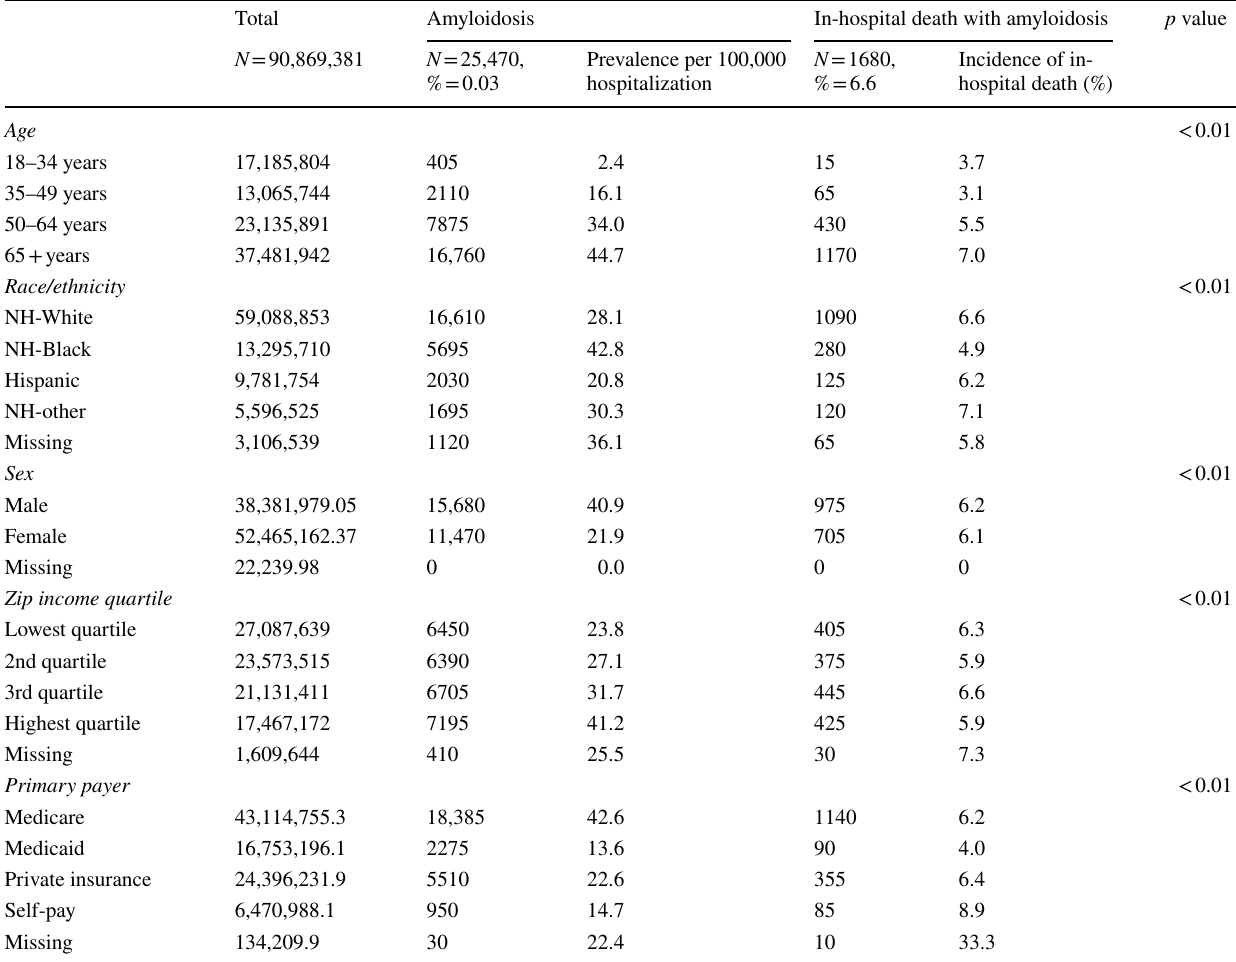
Table 1 Patient characteristics among those with Amyloidosis and those who experienced amyloidosis related in-hospital